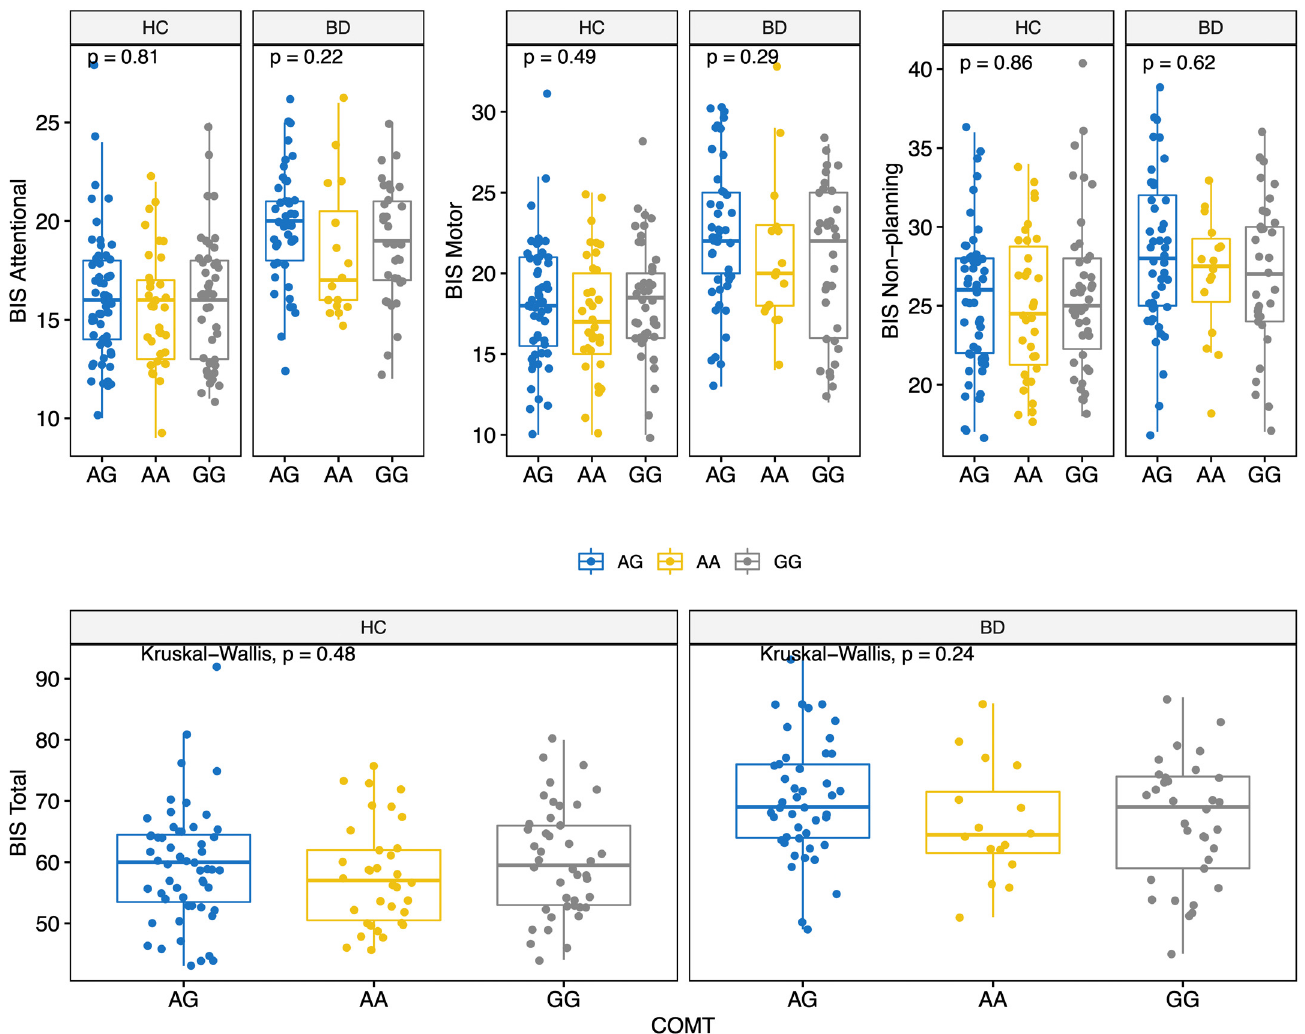
Figure 1. BIS-11 score (Attentional, Motor, Non-Planning and Total) by COMT polymorphisms for HC and BD.